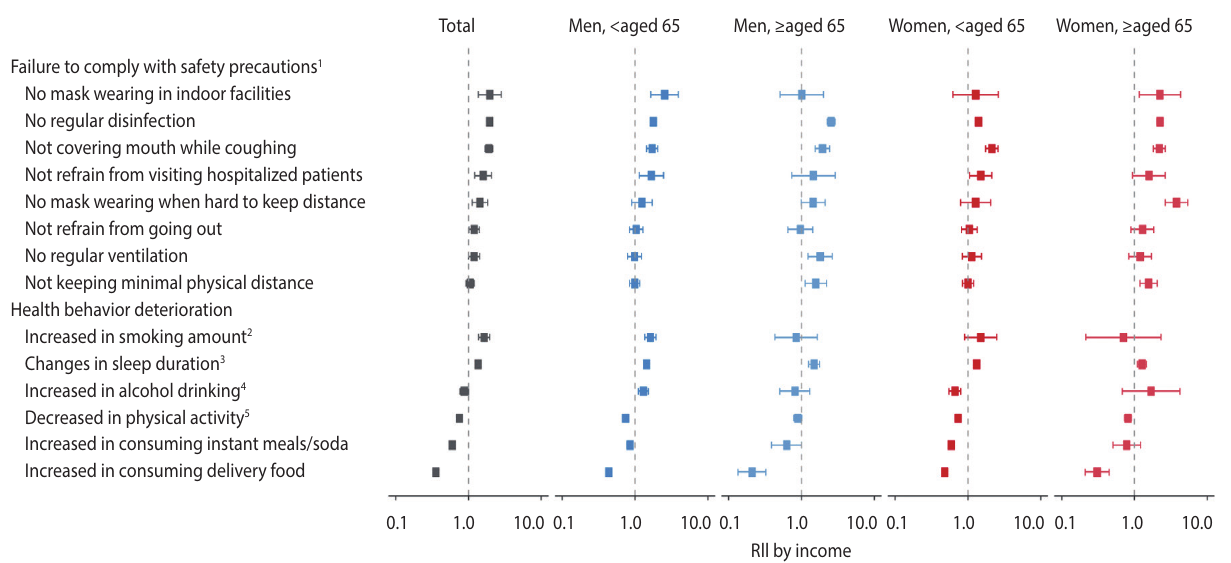
Figure 2. Relative index of inequality (RII) by income levels for failure to comply with coronavirus disease 2019 (COVID-19) safety precau- tions and health behavior deterioration in the total population and by gender and age. Questions were sorted by descending order of RII values in the total population analysis. 1 Adjusted for quarantine isolation experience due to COVID-19 infection and recent experience of fever/coughing. 2 Adjusted for smoking status (current/past). 3 Adjusted for sleep duration. 4 Adjusted for alcohol drinking frequencies. 5 Ad- justed for moderate physical activity